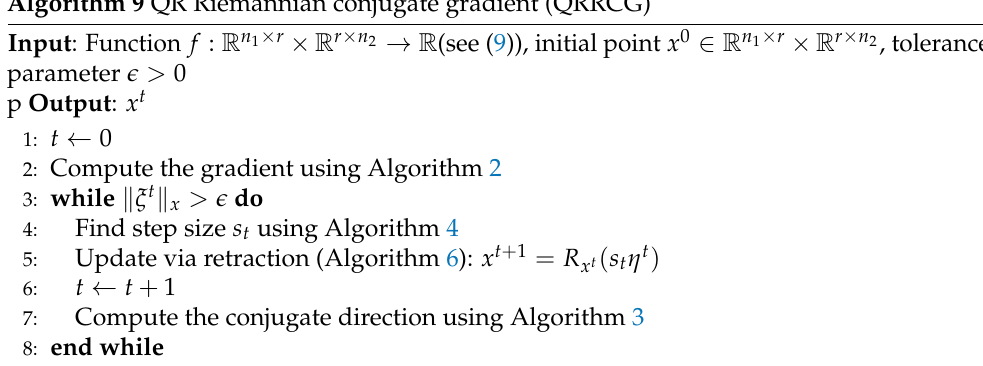
Algorithm 9 QR Riemannian conjugate gradient